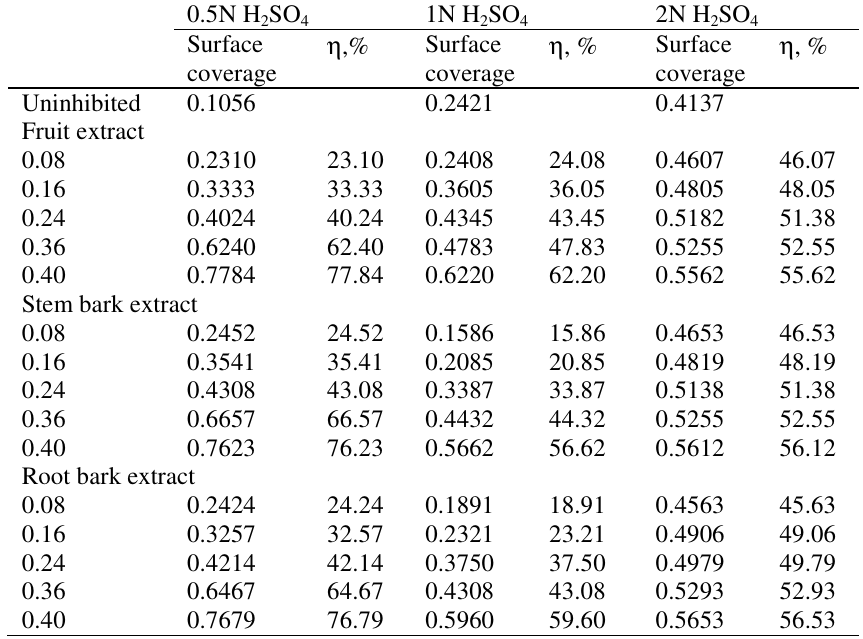
Table 4 . Surface coverage and inhibition efficiency for aluminium in sulphuric acid solution with given inhibitor addition at room temperature for Capparis decidua .